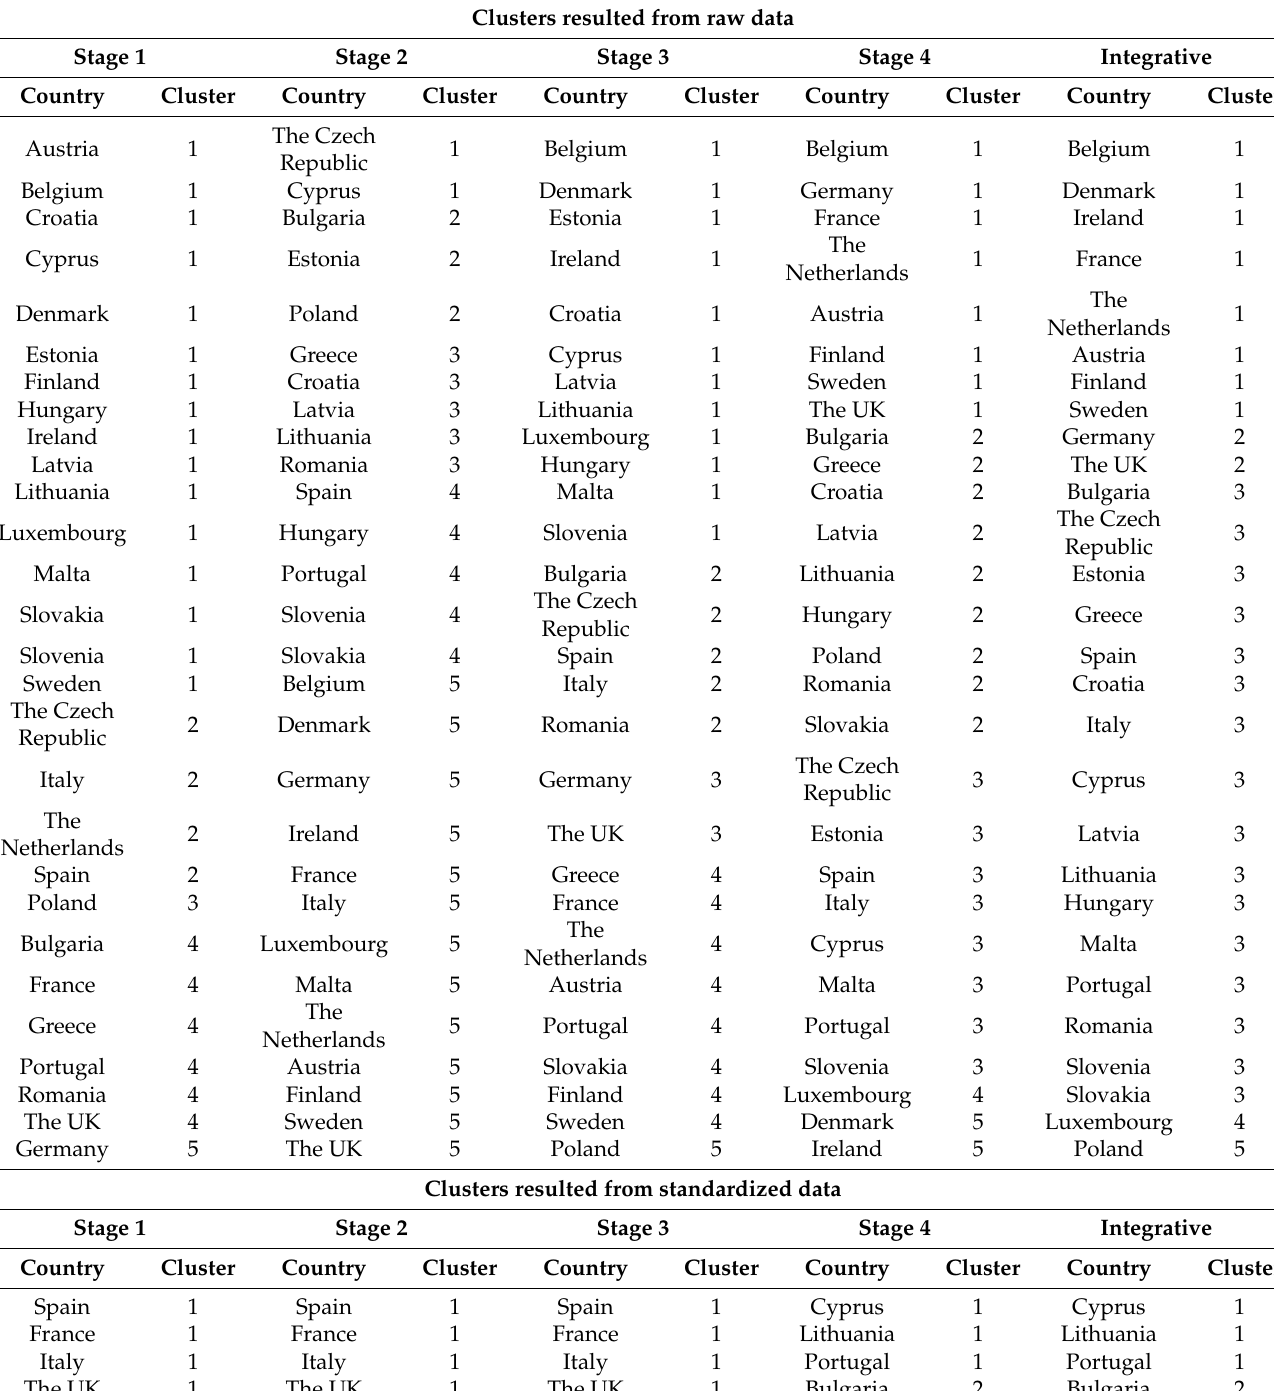
Table A1. Clusters resulted in the four stage process based on raw data and standardized